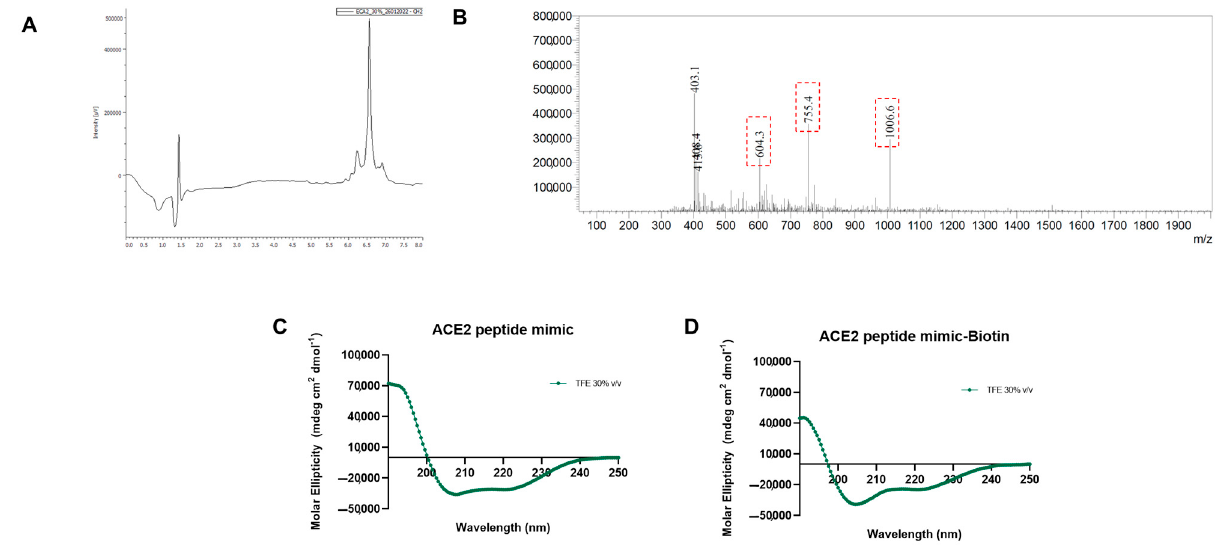
Figure 1. Mass and structure analysis of ACE2 peptide mimic. ( A ) RP-HPLC chromatogram of ACE2 peptide mimic, which was eluted at 6.7 min on a C18 column. ( B ) ESI-MS spectrum, showing the charged ion [M + 3H] 3+ (m/z 1006.4), [M + 4H] 4+ (m/z 754.8), and [M + 5H] 5+ (m/z 603.8) of synthetic ACE2 peptide mimic (MW 3019.204 Da). ( C , D ) Representative circular dichroism spectra for ACE2 peptide mimic and ACE2 peptide mimic biotin in trifluoroethanol 30% v / v in water.